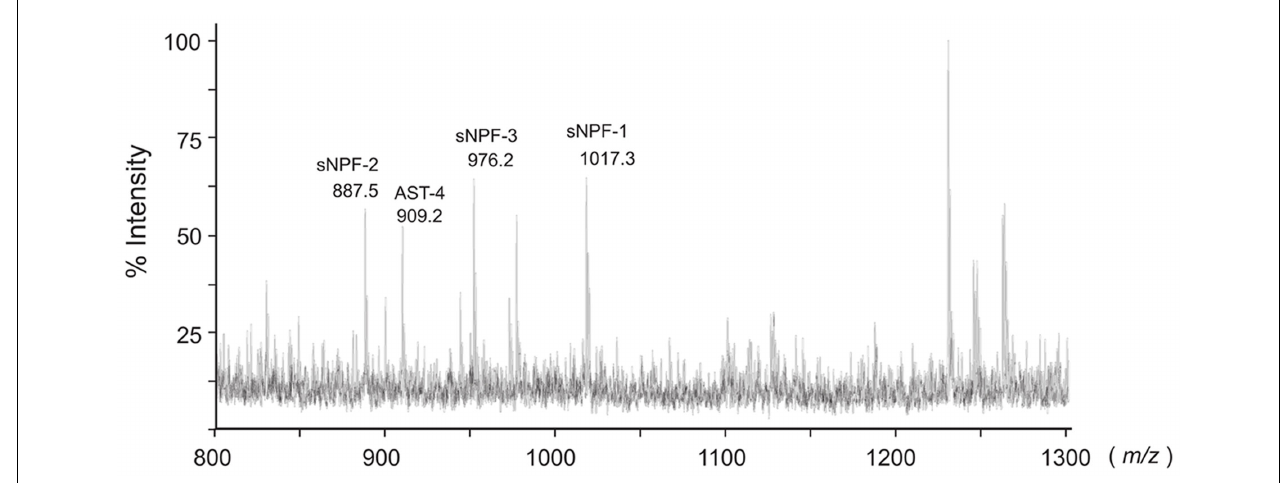
FIGURE 1 | Bombyx mori sNPF precursor and MS spectrum of B. mori larval brain. Representative MS spectrum of the B. mori larval brain. A fifth instar B. mori larval brain was isolated and directly analyzed by MALDI-TOF MS.The B. mori genomic database was used to facilitate identification of ion peaks in the